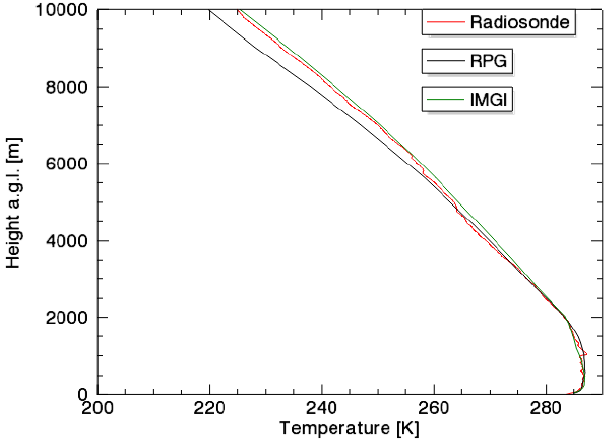
Figure 5. Temperature profile within the full troposphere. The com- parison is between (differently colored lines, see inlet) radiosonde, RPG algorithm, IMGI algorithm. They refer to 9 September 2012 at 01:58UTC (launch time of the radiosonde). The height is expressed in meters above